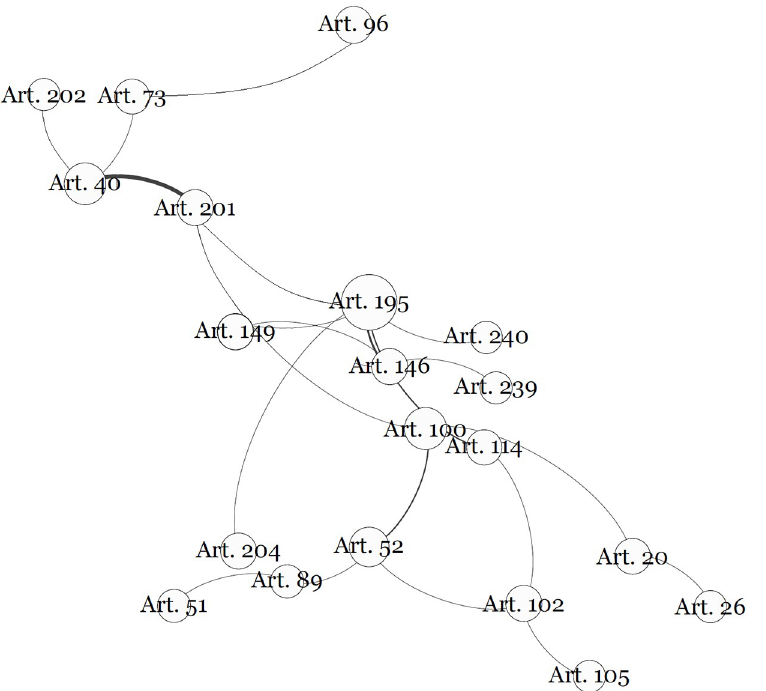
Fig 6. Financing social security and its constitutional text